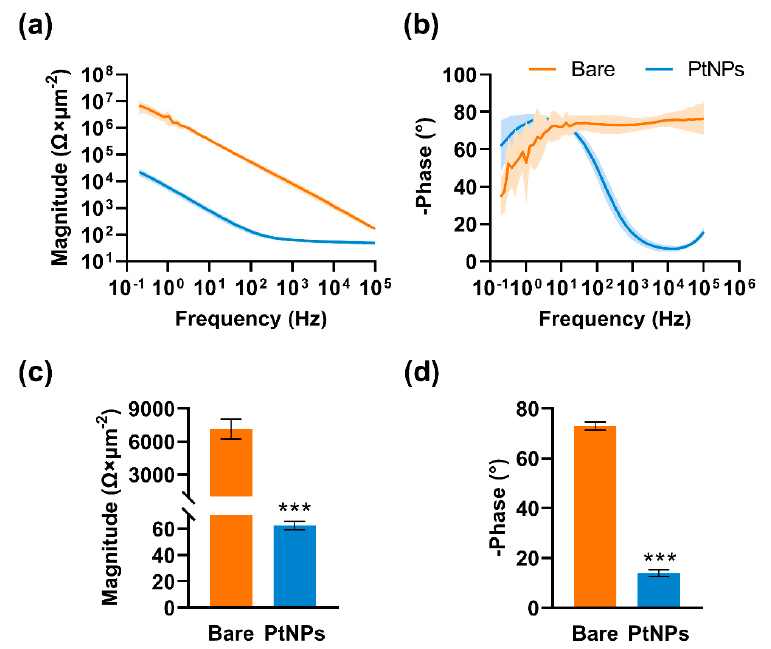
Figure 4. Impedance magnitude and phase assessment. ( a ) and ( b ) Electrode impedance magnitude and phase distribution before and after PtNP modification. ( c ) The average impedance magnitude of electrodes at 1 kHz decreased from 7125.89 ± 900.7 Ω / μ m 2 to 62.30 ± 3.28 Ω / μ m 2 . ( d ) The phase changed from – 72.98 ± 1.65° to – 13.93 ± 1.36°. *** P < 0.001, paired t ‐ test, n = 10 for each